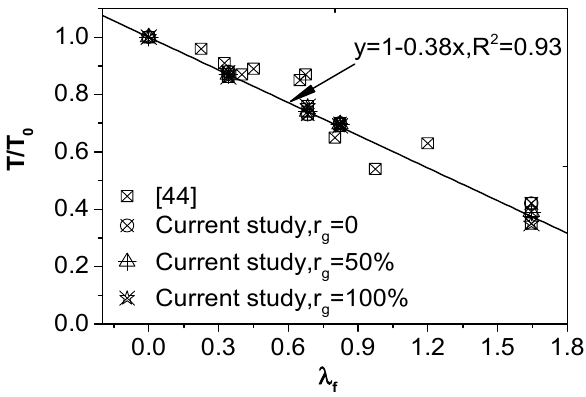
Figure 4. Relation between T / T 0 and λ f .